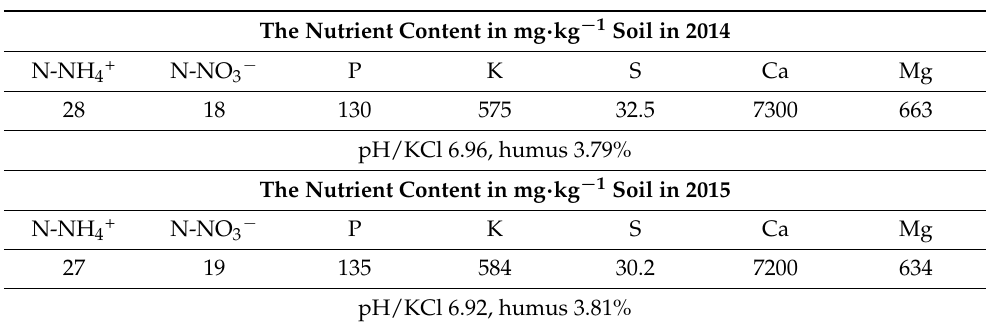
Table 3. Soil nutrients content in the